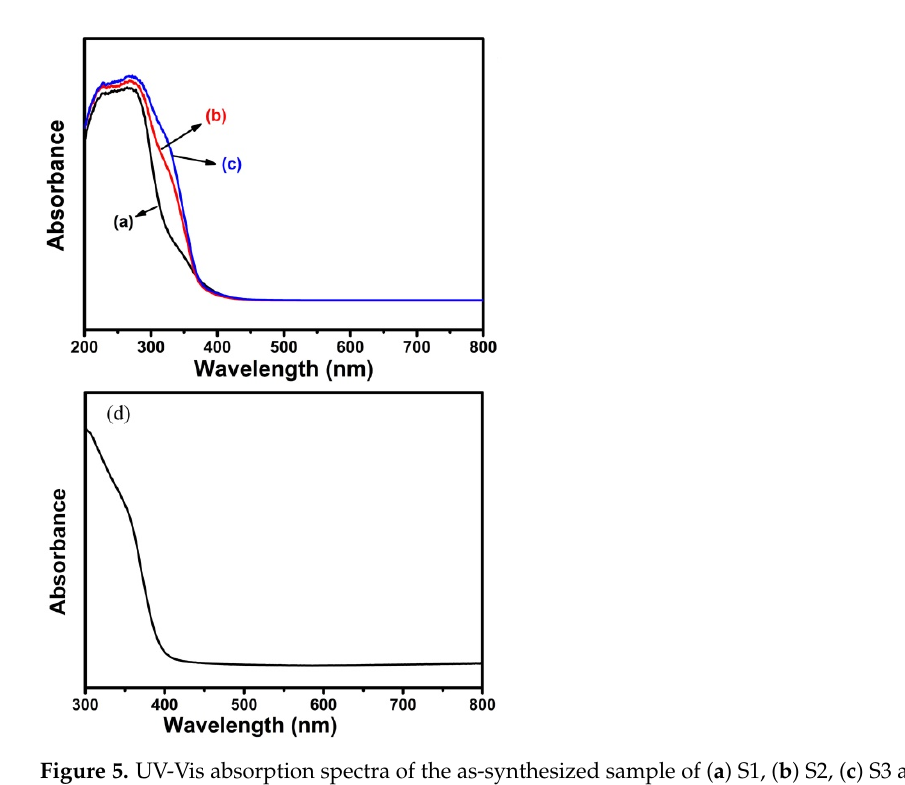
Figure 4. The photocatalytic H 2 evolution rate of water splitting under UV light ( λ < 420 nm) irradiation of as-prepared samples: blank sample, S1, S2 and S3.